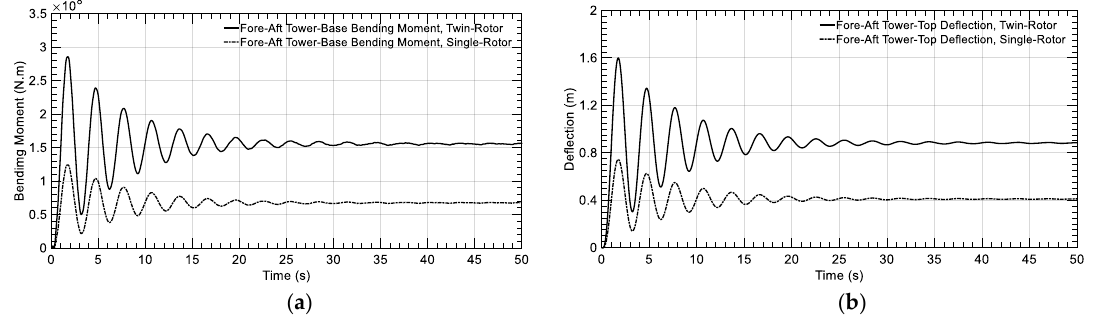
Figure 21. Dynamic responses of the tower: single-rotor vs. twin-rotor load case 1: ( a ) tower-base, fore-aft bending moment, and ( b ) tower-top, fore-aft